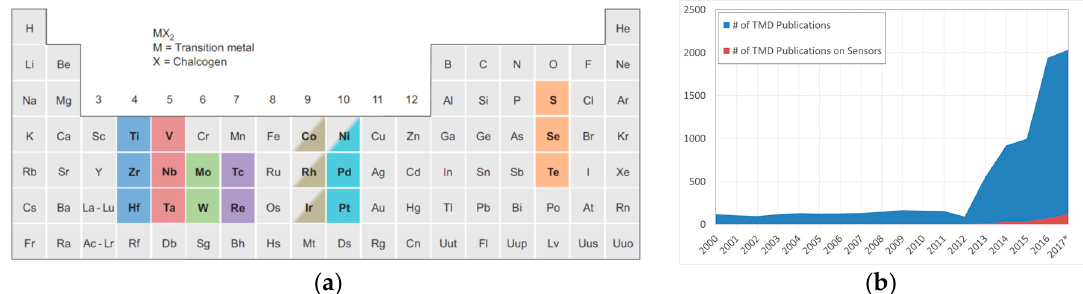
Figure 1. ( a ) Periodic table with highlighted the transition metals and chalcogen elements (S, Se and Te) that form crystalline in 2D layered structures. Co, Rh, Ir and Ni are partially highlighted because only some dichalcogenides form layered structures. Reprinted by permission from Macmillan Publishers Ltd: Nature Chemistry [7], copyright (2013). ( b ) Number of publications per year on TMDs (in blue) and on TMD-related sensing devices (in red), calculated from fully highlighted materials reported in Figure 1a. * The 2017 data are partial (source SCOPUS, Elsevier B.V.).